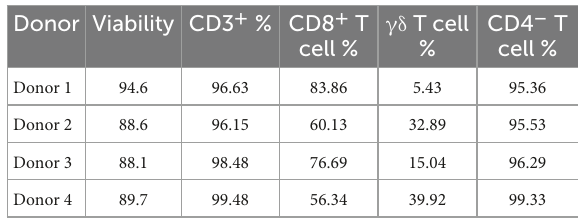
TABLE 2 With the AIM platform a highly pure population of T cells is consistently generated for